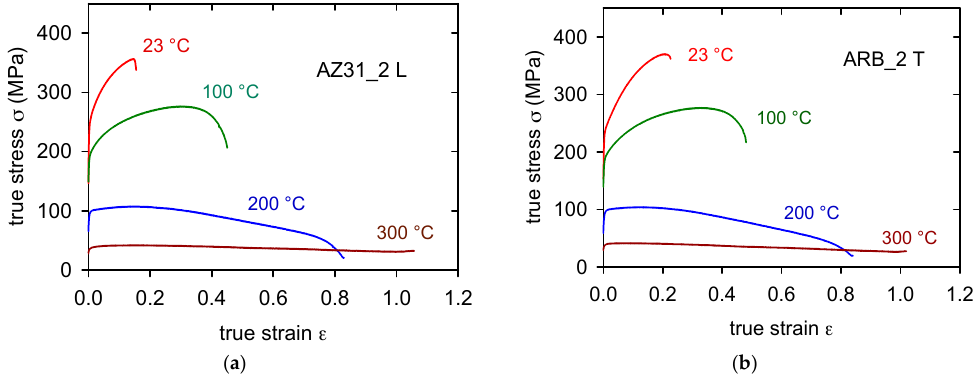
Figure 9. True stress—true strain curves obtained at various temperatures for L-samples ( a ) and T-samples ( b ) after two passes through the rolling mill.